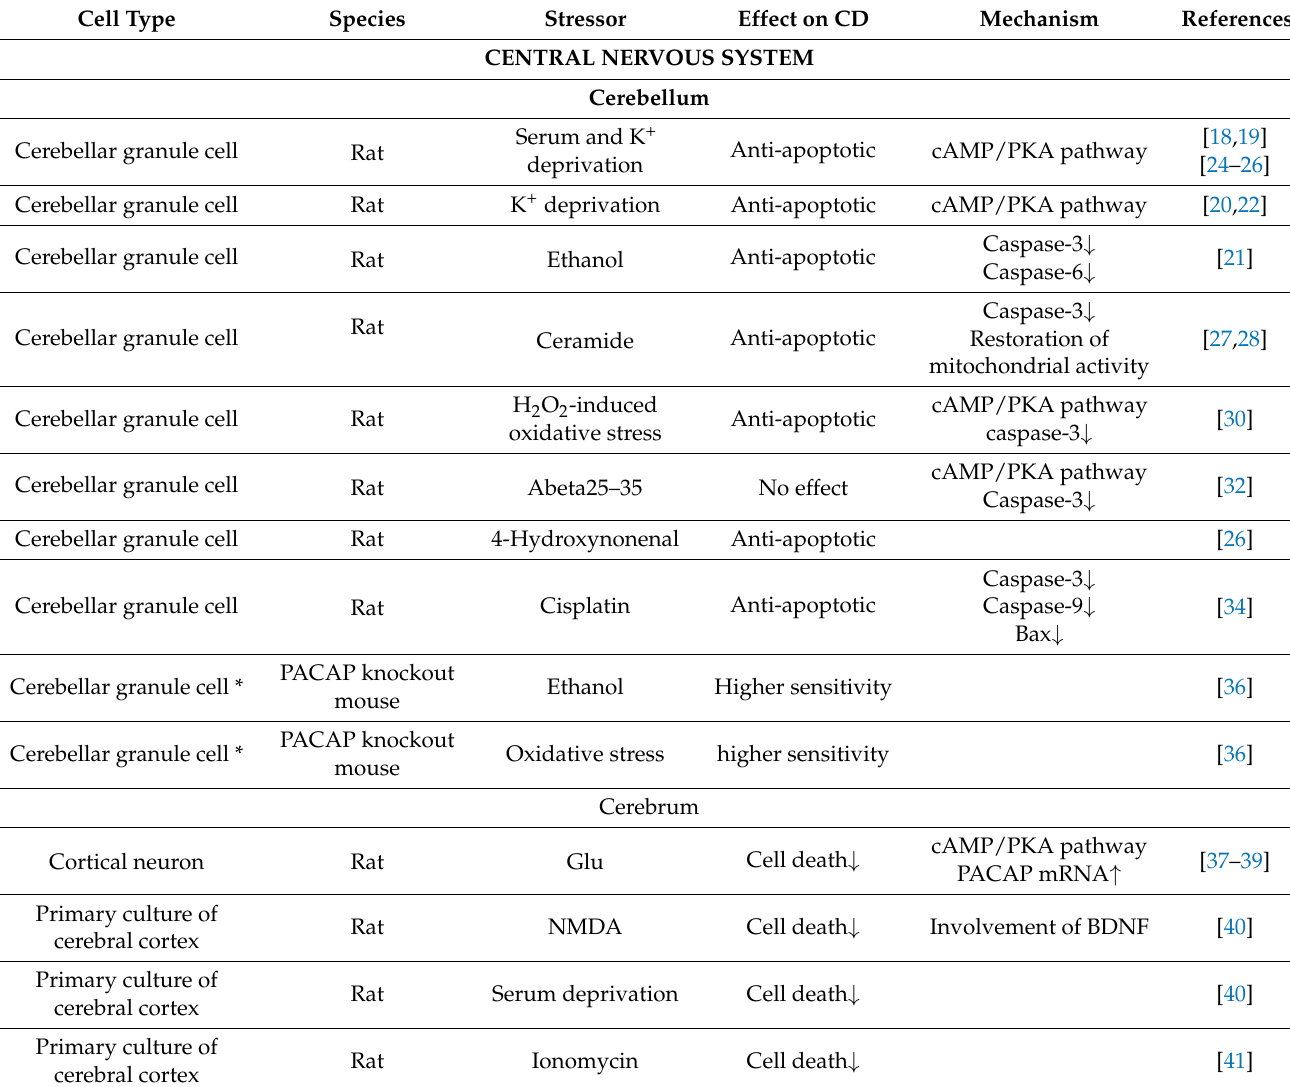
Table 1. Effects of exogenous and endogenous PACAP in vitro on cell death (CD) in the nervous system. In case the type of cell death was not specified in the cited study, the term “cell death” was used. * shows effects of endogenous